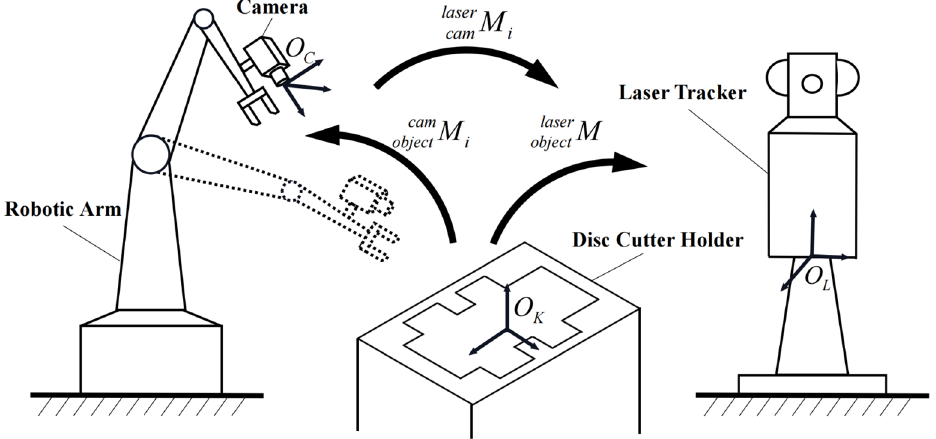
Figure 18. The schematic diagram of relative pose measurement. Table 7. Steps of the accuracy verification experiment.